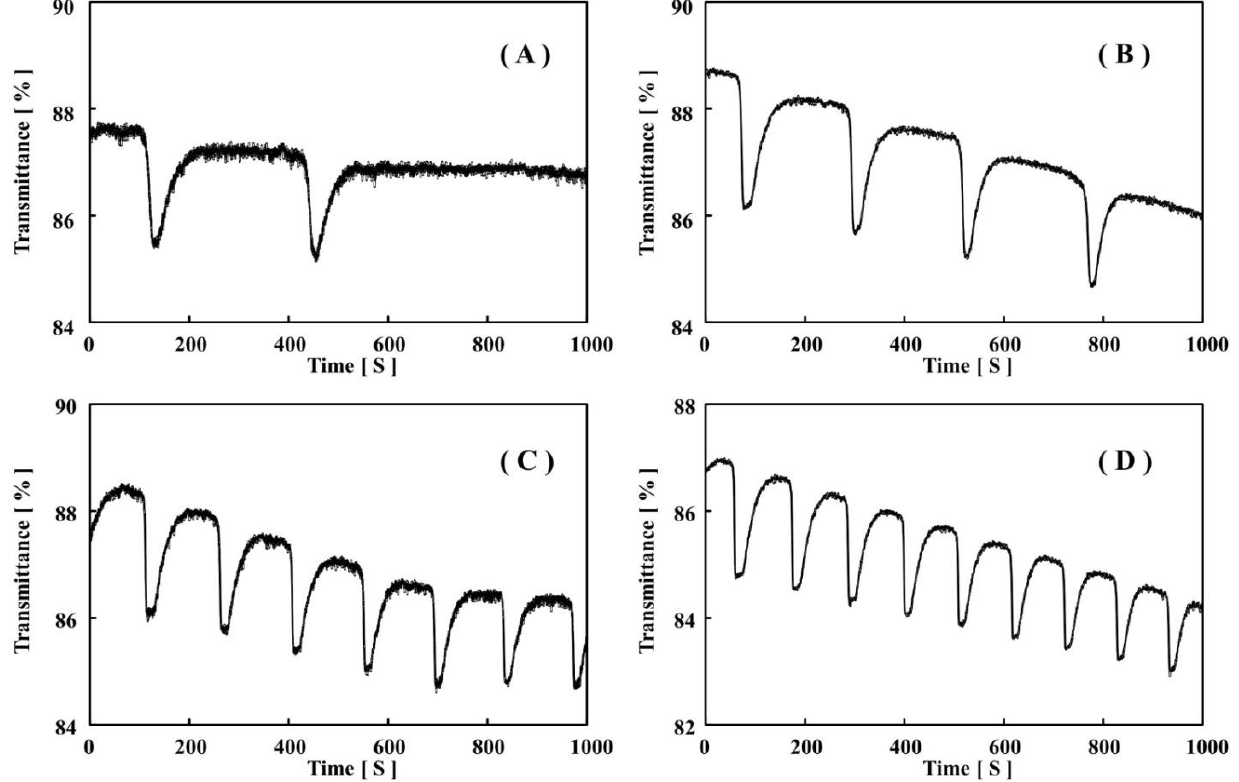
) 3 ] = 0.3 M, [MA] = 0.1 M) 3